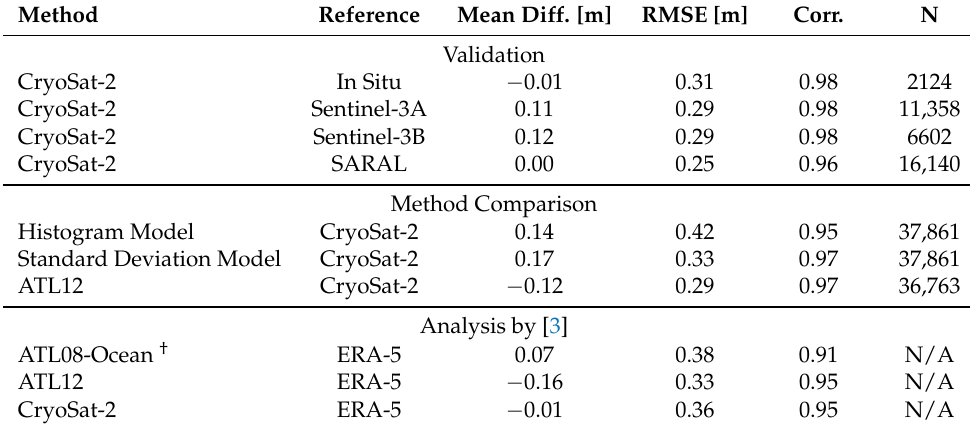
Table 4. Collection of the comparisons done in this study, including the validation of CryoSat-2, comparisons between the methods derived in this paper and CryoSat-2, and the comparison of similar methods with ERA-5 [3] ( † ATL08-Ocean determines the SWH from the individual surface waves, like the histogram